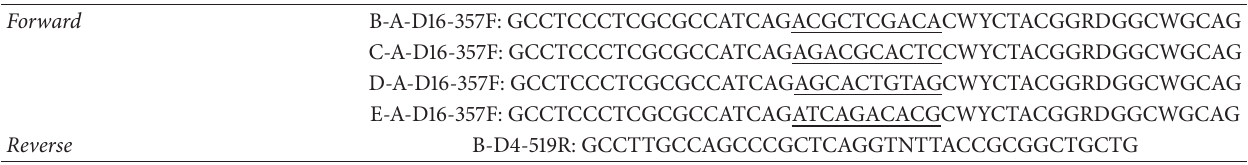
Table 1: Barcoded degenerate primers used to produce the V3 amplicon